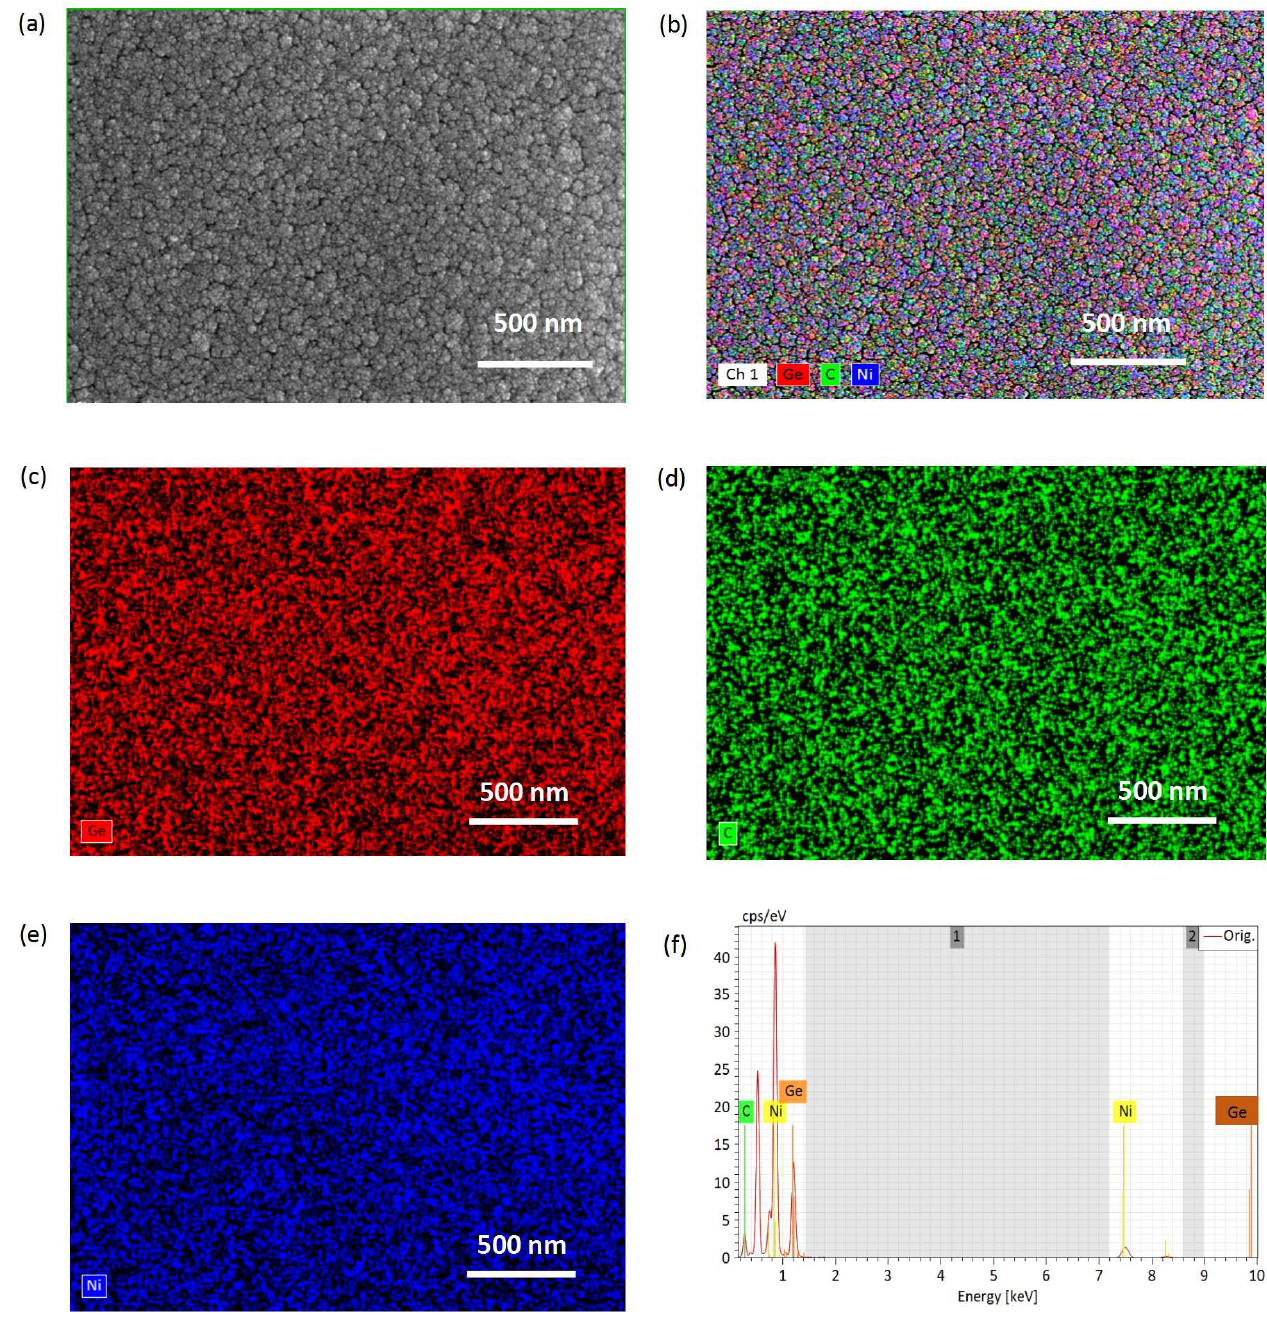
Figure 5. SEM images: ( a ) the surface part of the Ge composite film, ( b ) the mapping pattern of Figure 3a, ( c ) the Ge element distribution map, ( d ) the carbon element distribution map, ( e ) the nickel element distribution map, and ( f ) the element mapping of the Ge, carbon, and